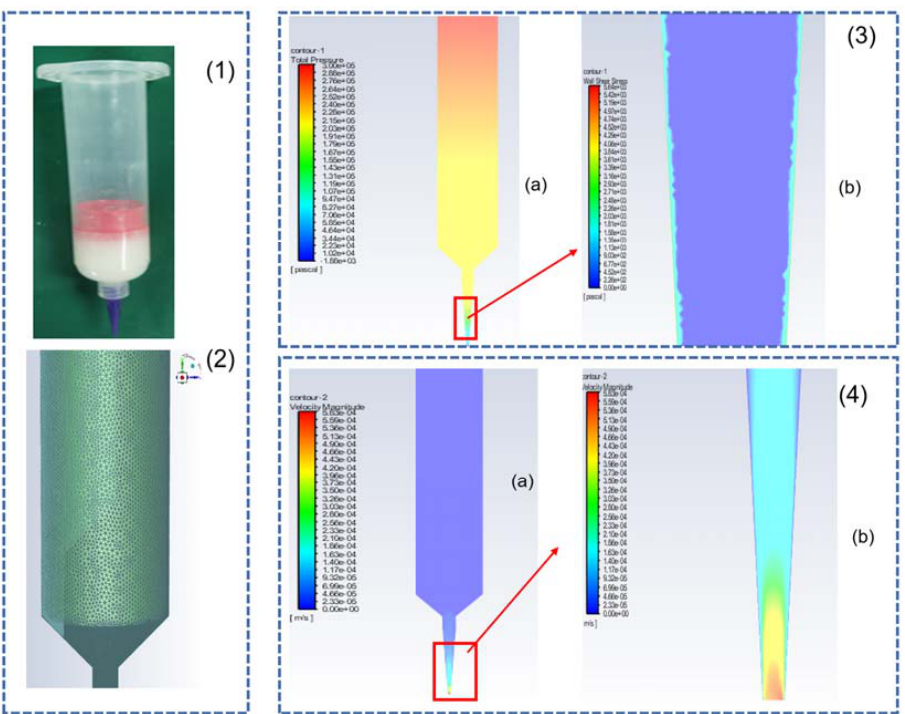
Figure 4. Extrusion process model construction and simulation results: ( 1 ) The original structure of the extrusion bin; ( 2 ) The mesh model of the extrusion bin; ( 3 ) The pressure gradient distribution from: ( a ) Pressure distribution; ( b ) The magnifications of the print nozzle’s internal shear force distribution; ( 4 ) The change of the material flow rate at different positions: ( a ) the change of the material flow rate Overall drawing; (b) The magnified view of the flow rate variation at the print nozzle position